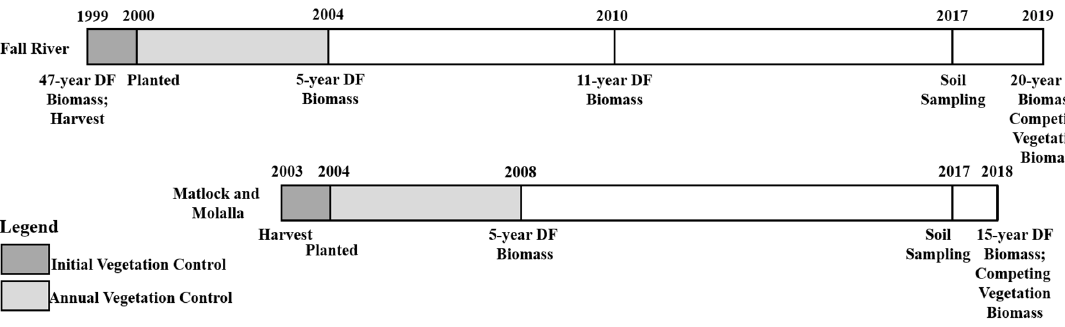
Figure 2. Timeline of harvest, planting, and vegetation control, and Douglas-fir (DF) and competing vegetation biomass and soil sampling at the three sites.